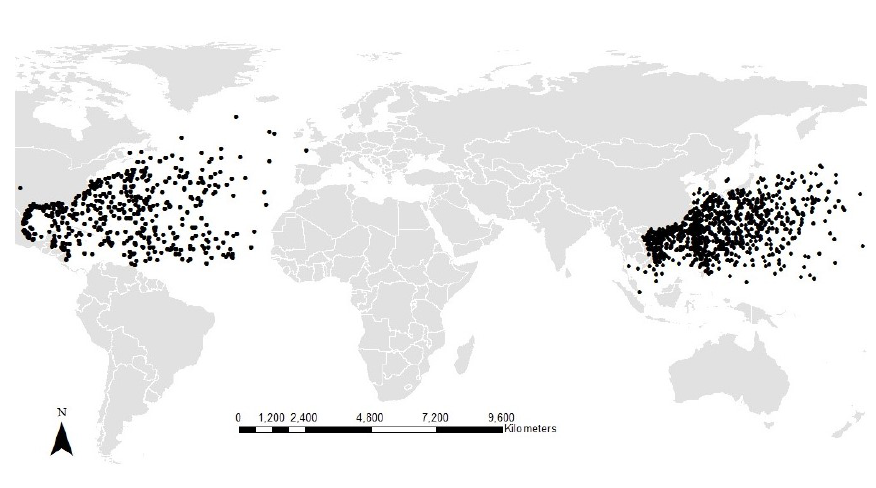
Figure 2. Lifetime maximum intensity (LMI) locations for TCs with wind speeds ≥ 18 ms − 1 from 1977–2015 in the North Atlantic and West Pacific